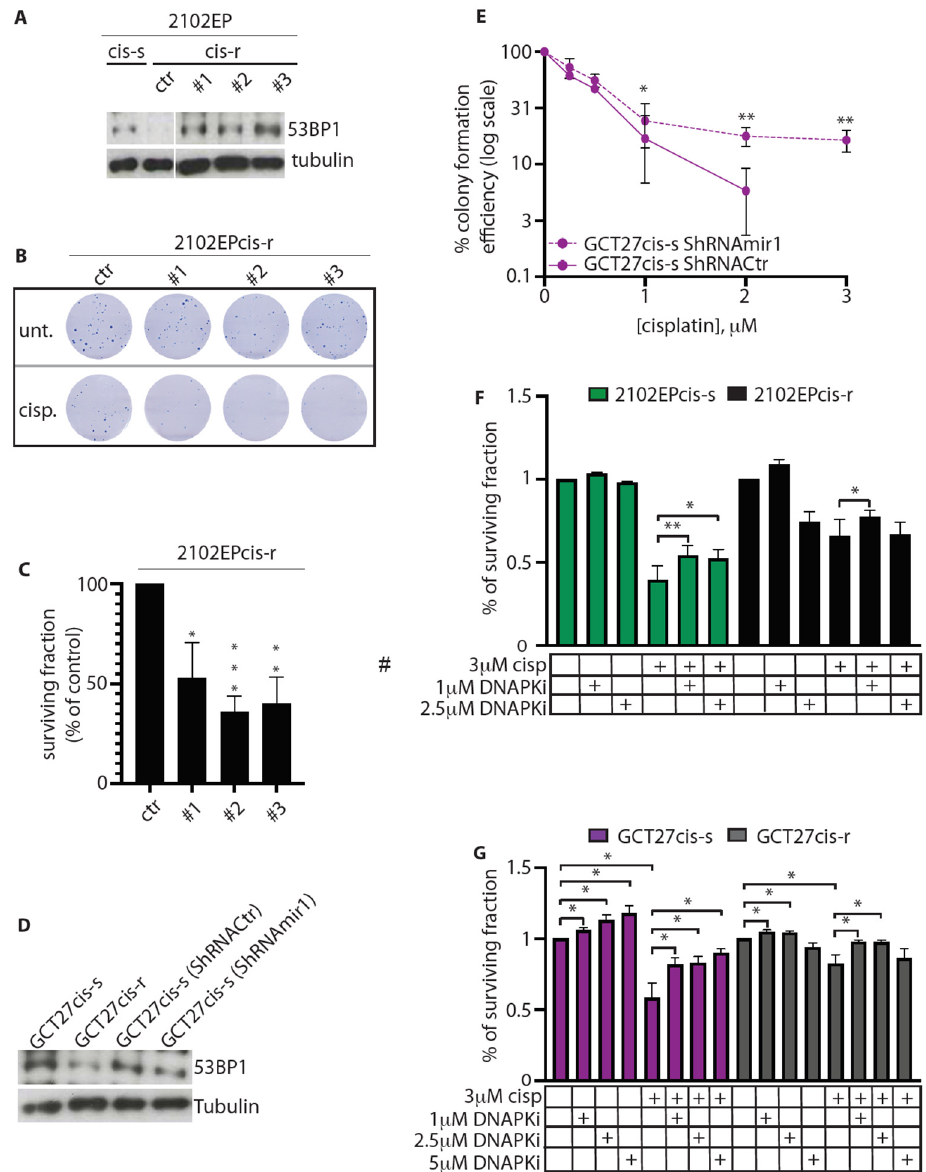
Figure 5. ( A ) Western blotting analyses of 53BP1 expression in 2102EP cells. Here, #1, #2, #3 are clones of 2102EPcis-r cells overexpressing 53BP1 at a level comparable to that of cis-s cells. Ctr indicates the level of 53BP1 protein in naïve 2102EPcis-r cells. Tubulin was used as loading control. Original blots see Figure S3F. ( B ) Colony assay of control and 53BP1-overexpressing clones of 2102EPcis-r after treatment with a pulse of 3 µ M cisplatin for 6 h. Ctr = cells transfected with a control vector; Unt. = untreated; cisp. = cisplatin-treated. ( C ) Quantification of surviving colonies of the indicated 2102EPcis-r cells, treated as described in ( B ). ( D ) Western blotting analyses of 53BP1 expression in GCT27 cells. GCT27cis-s and GCT27cis-r are non-infected paired clones. GCT27cis-s ShRNACtr are cells infected with a non-specific shRNA, while GCT27cis-s ShRNAmir1 are cells infected with an shRNA specific to 53BP1. Tubulin was used as a loading control. Original blots see Figure S3F. ( E ) Colony assay of GCT27 cell lines infected with either ShRNACtr or ShRNAmir1. Data are mean values ± s.d. of three independent experiments. ( F , G ) Surviving fraction of the indicated cell lines after treatment with either cisplatin or cisplatin combined with DNA-PKi. Survival was evaluated by crystal violet assay. Data are mean values ± s.d. of either three (GCT27) or six (2102EP) independent experiments. Statistical analyses were performed using the unpaired two-tailed ( C , F , G ) or one-tailed ( E ) t -test (* p < 0.05; ** p < 0.01; *** p < 0.0001).